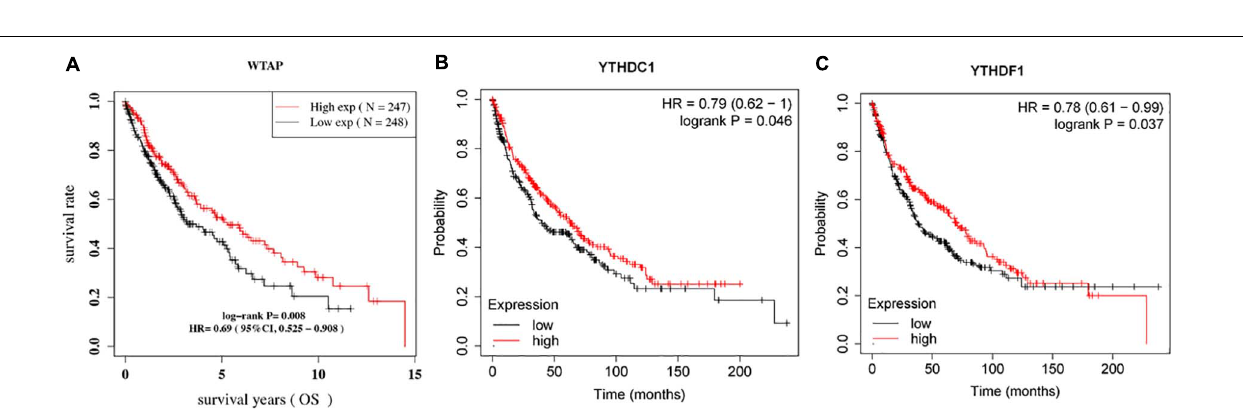
FIGURE 5 | Survival curves according to the expression of (A) WTAP; (B) YTHDC1; and (C) YTHDF1.